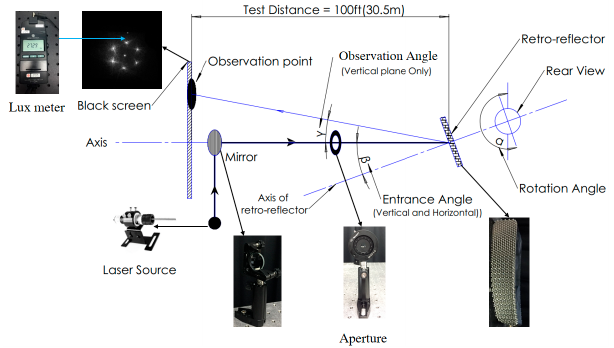
Figure 10. Experimental setup for curved corner-cube retroreflector (CCCR) testing.